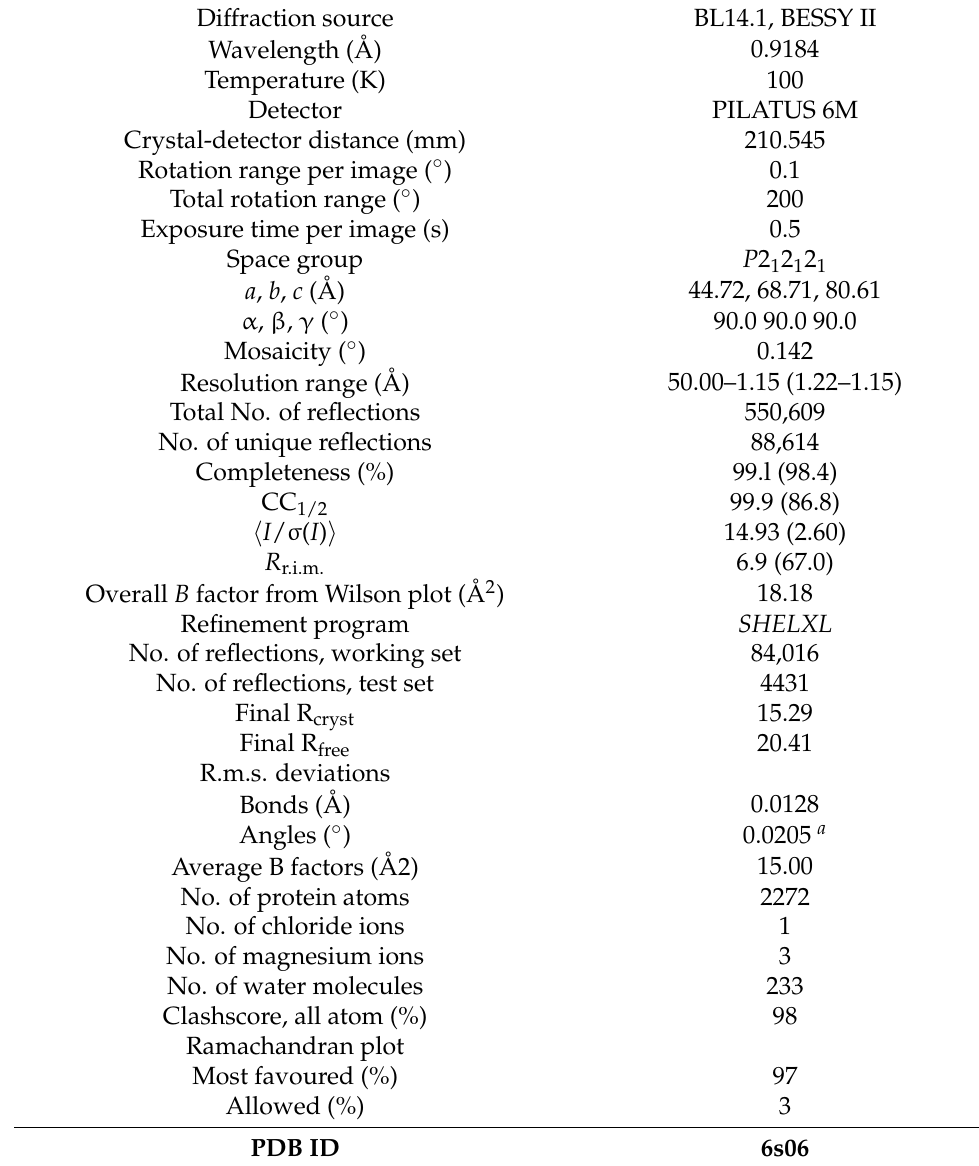
Table 2. Data processing, structure determination and refinement statistics of LinB D147C+L177C variant. Values in parentheses are for the highest resolution